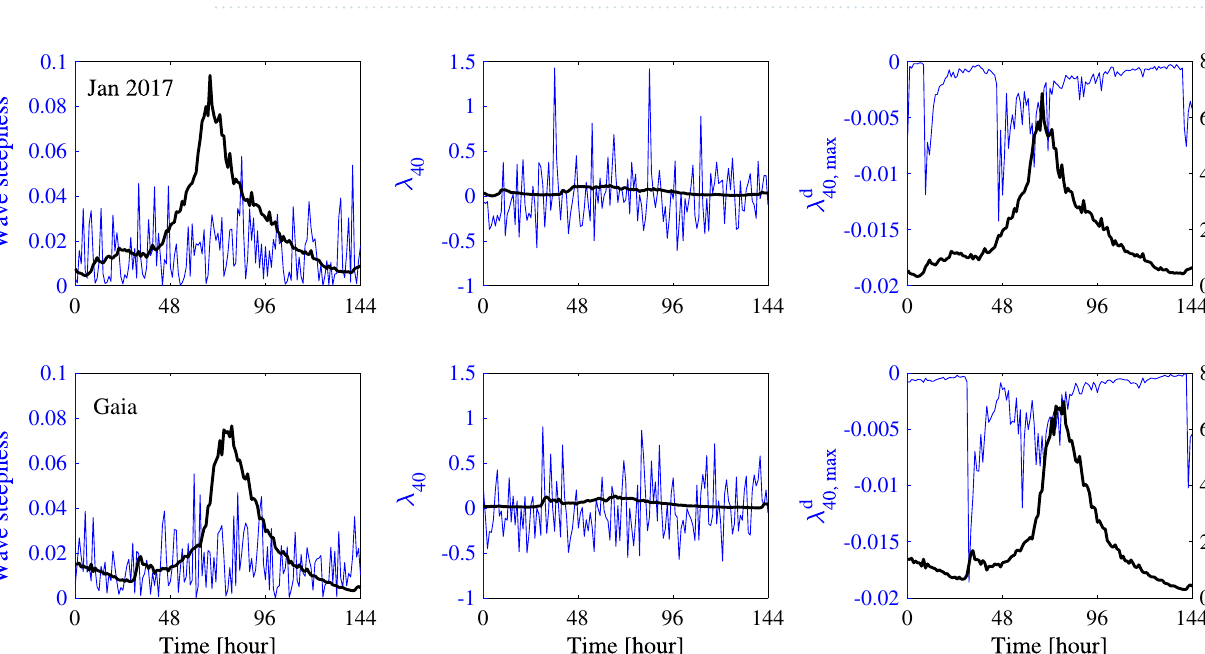
Figure 4. Statistical parameters history during storms (top panels) Jan 2017 and (bottom panels) Gaia: (left) hourly variation of the theoretical NB (bold line) and observed Tayfun steepness µ (center) observed excess kurtosis (thin blue line) and NB estimate (bold line) and (right) theoretical maximum NB dynamic excess kurtosis 19 (blue thin line). The significant wave height history is also reported (black